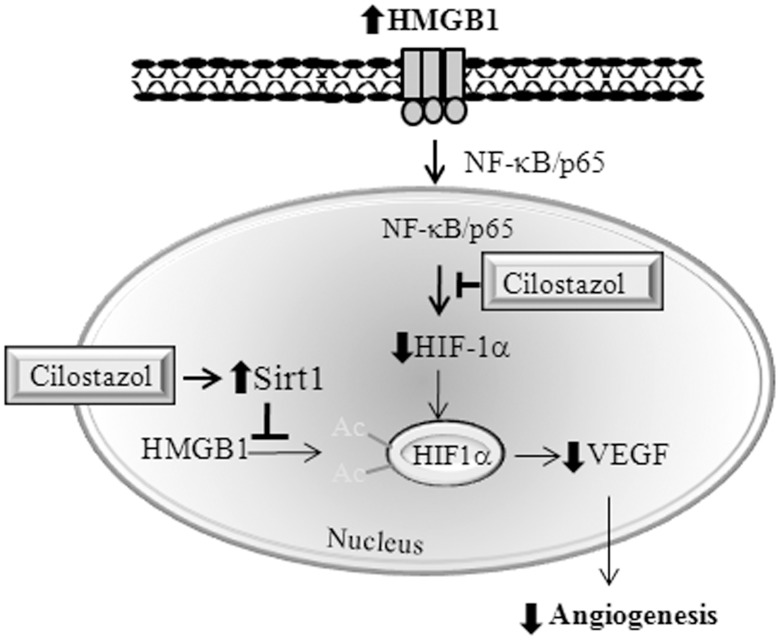
Hypothetical model.Scheme illustrating the dual effects of cilostazol, namely, (1) its inhibition of HMGB1-activated NF-κB nuclear translocation and subsequent HIF-1α expression, and (2) its inactivation of HIF-1α by increasing SIRT1 deacetylase activity in RA SFs. These effects lead to the down-regulation of VEGF and to the inhibition of synovial angiogenesis.